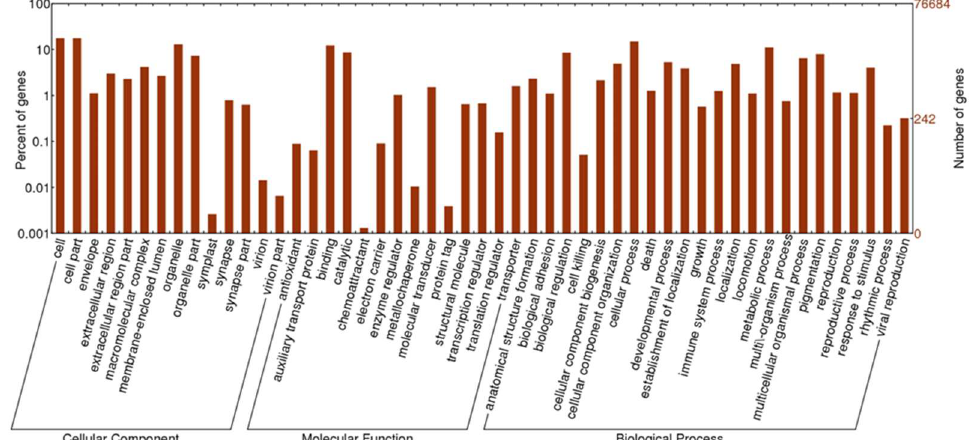
Figure 3. Functional annotation of assembled sequences based on Gene Ontology (GO)